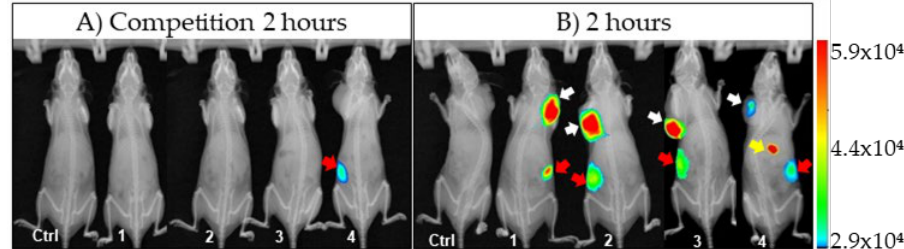
Figure 4. Comparative images acquired two hours post-injection of: ( A ) Sgc8-c-NH 2 + Sgc8-c-Alexa647; ( B ) Sgc8-c-Alexa647 alone. Arrows indicate fluorescent signals detected in vivo (white = tumors; yellow = liver and gallbladder; red = kidneys). Aptamer-probe-injected mice (1, 2, 3 and 4) and PBS-injected mice (Ctrl).